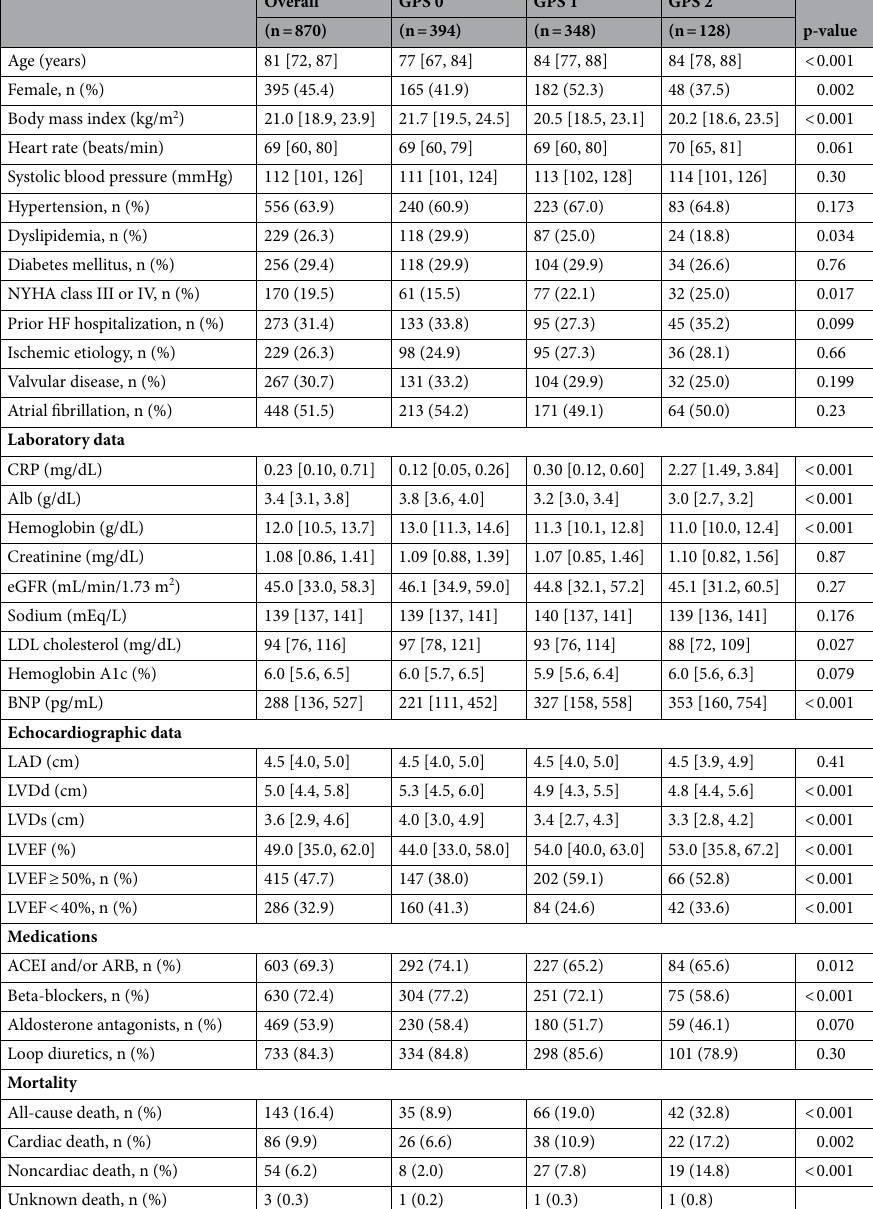
Table 1. Patient characteristics. Continuous variables are summarized as the median and interquartile range. Comparisons between patient groups were performed using the Kruskal–Wallis test for continuous variables and by means of contingency table analysis and Fisher’s exact test for categorical variables. ACEI angiotensin- converting enzyme inhibitor, Alb albumin, ARB angiotensin-receptor blocker, BNP B-type natriuretic peptide, CRP C-reactive protein, Dd end-diastolic diameter, Ds end-systolic diameter, EF ejection fraction, eGFR estimated glomerular filtration rate, GPS Glasgow Prognostic Score, HF heart failure, LAD left atrial dimension, LDL low-density lipoprotein, LV left ventricular, NYHA New York Heart